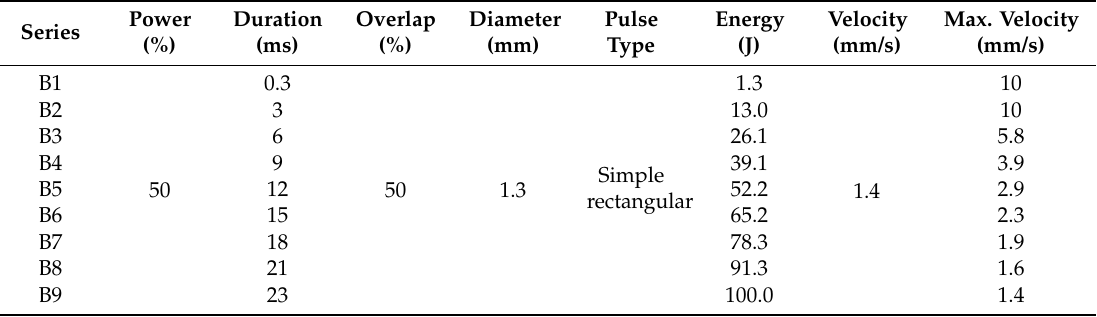
Table A3. Experimental plan for the effects of overlap on weld penetration.